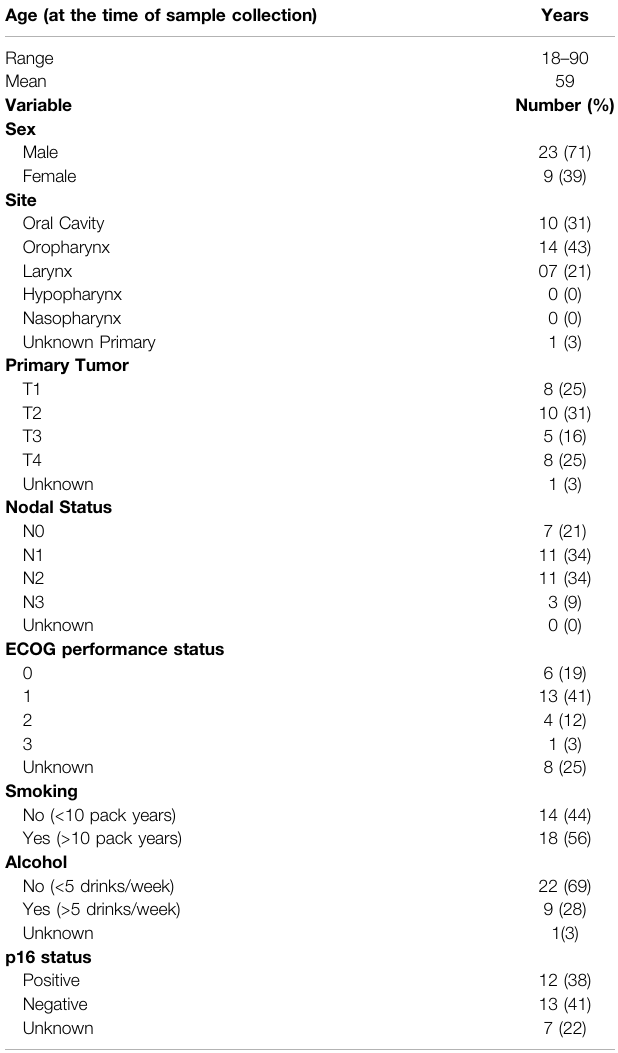
TABLE1| DemographicandclinicaldataofHNSCCpatientsenrolledinthestudy. Age (at the time of sample